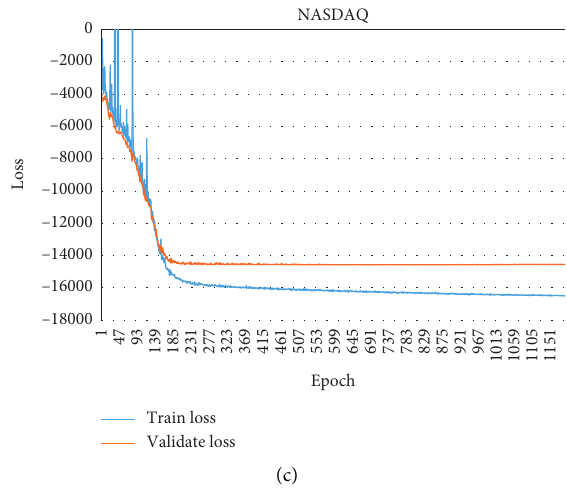
Figure 5: The learning curves when training DNN (likelihood-based loss).